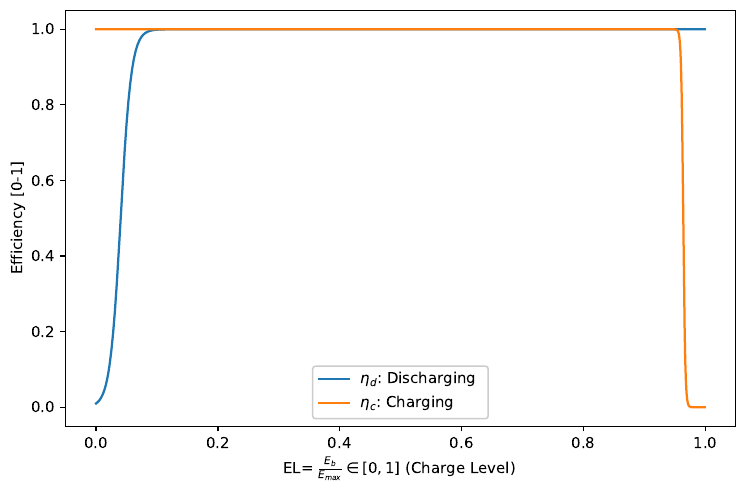
Figure 5. Efficiency factors η c and η d modelled using logistic functions with parameters α = 0.04 and β =